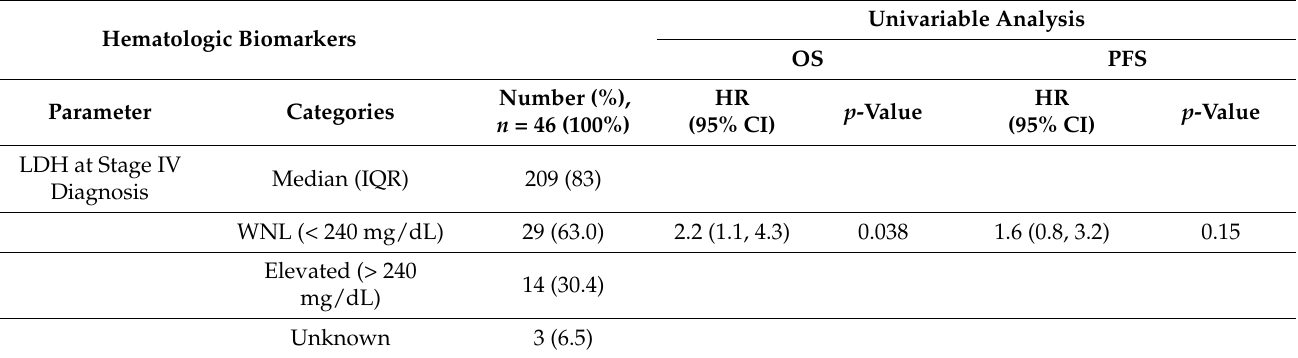
Table 3. Hematologic